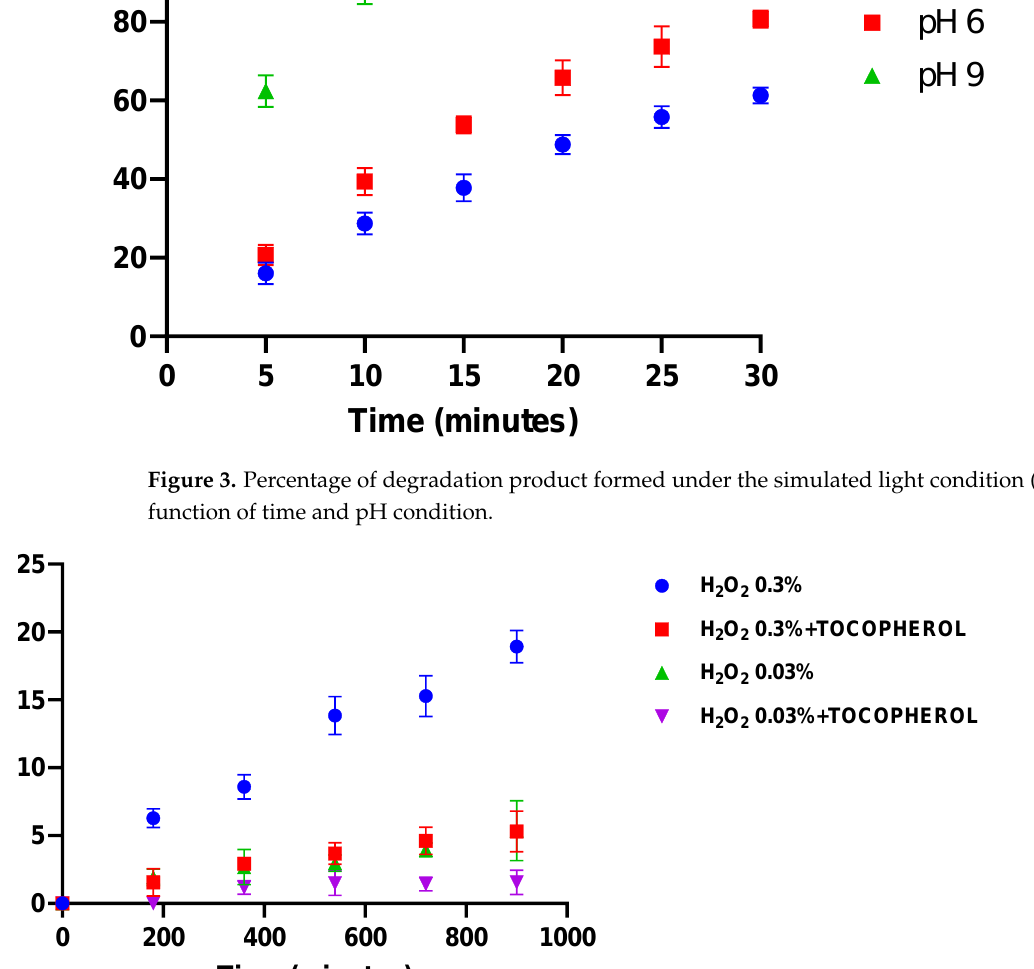
Figure 4. Percentage of degradation product formed under oxidative stress (DP2) as a function of time and in the presence of tocopherol.